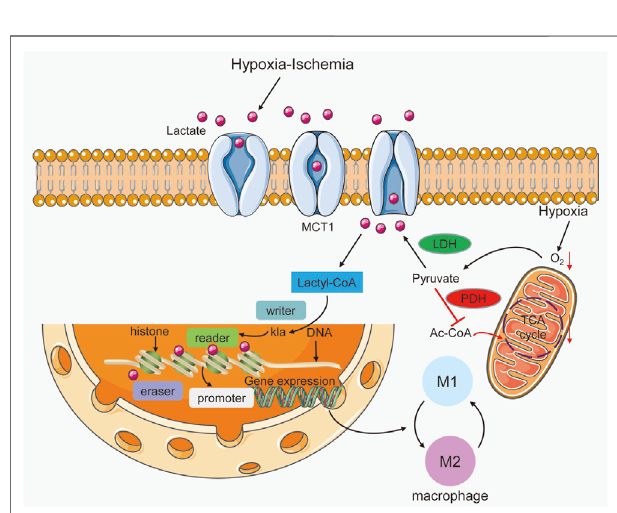
FIGURE 2 | Lactate acts as a signaling molecule in macrophages to trigger epigenetic changes caused by histone lysine lactylation. Hypoxia- ischemia can increase lactate production and entry into macrophages. In addition, hypoxia triggers the promotion of lactate by increasing glycolysis and inhibiting the Krebs cycle. Lactyl-CoA synthetase converts lactate to lactyl-CoA and further induces histone kla at the promoter, which is controlled by writer, eraser and reader enzymes. In gene promoter regions, histoneklacanregulategenetranscriptionandcausealterationsinM1andM2